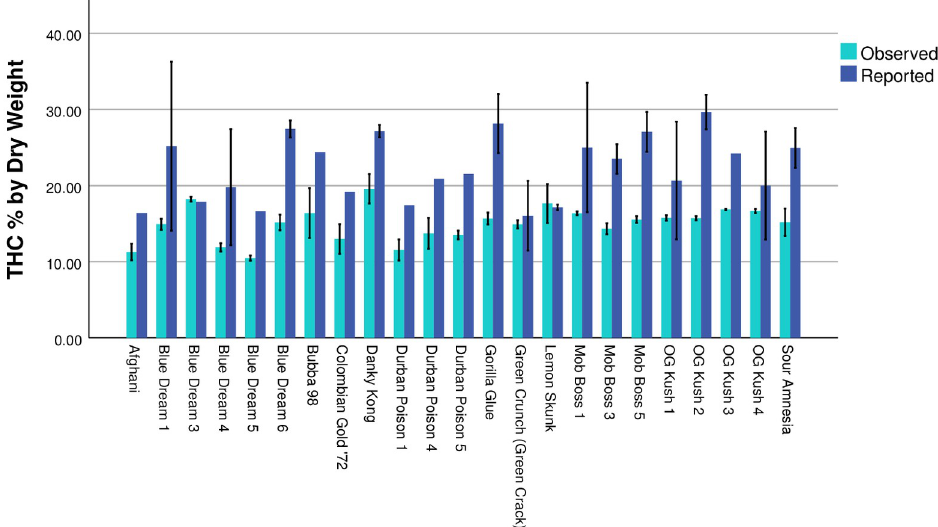
Fig 2. Mean THC % by dry weight for observed vs. reported values. Each Cannabis sample is indicated along the x- axis, and error bars show the standard deviation. Samples are grouped by the dispensary they were purchased from. For samples with a reported range of THC % by dry weight, the mean of those values is presented. Reported values with no error bar were sold with a single number for THC % by dry weight.